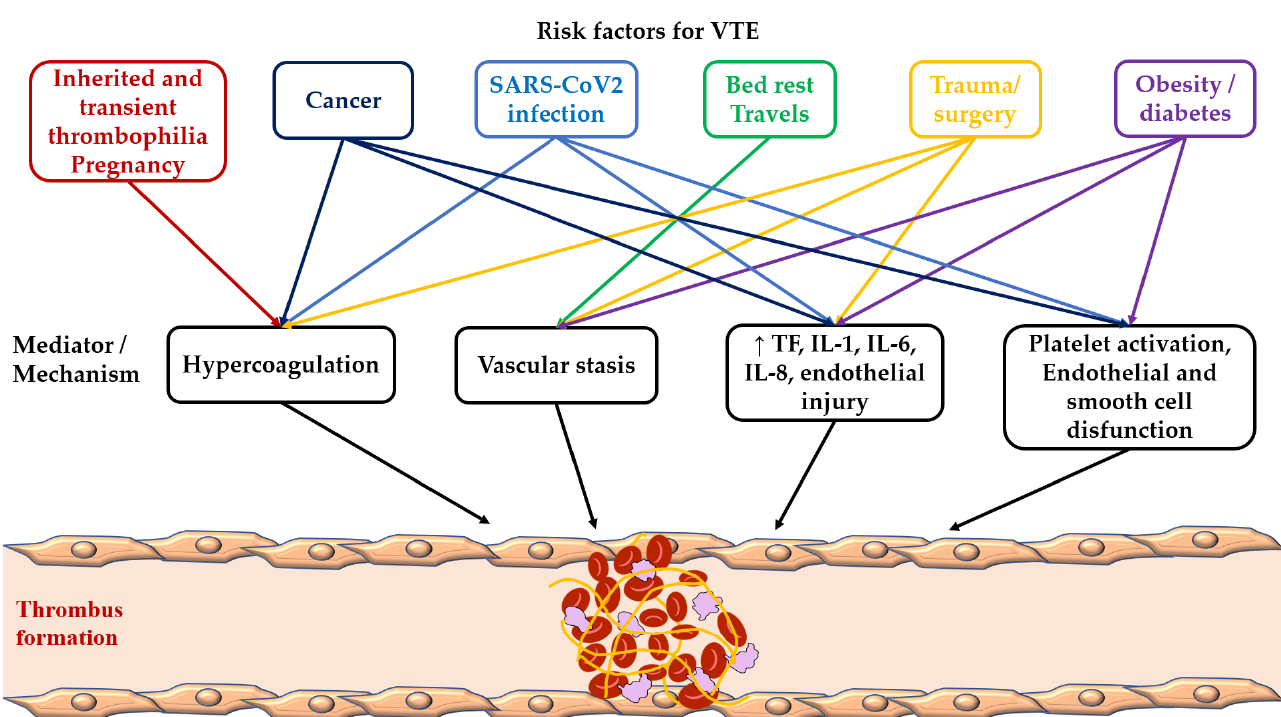
Figure 2. Risk factors and mediators of venous thromboembolism.